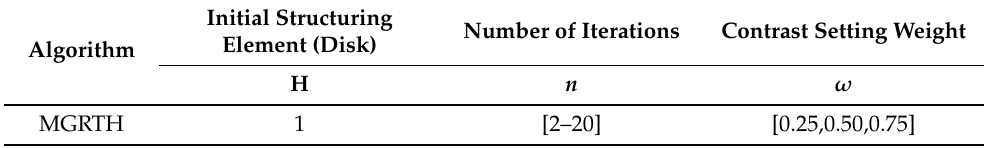
Table 1. Parameters of the proposed